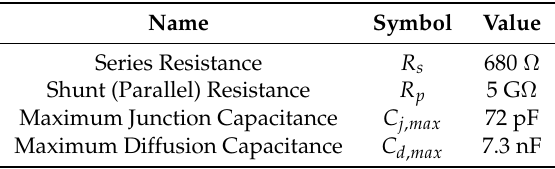
Figure 3. The photodiode equivalent circuit. The current source I pv outputs relative to the luminous intensity. The parasitics include the series resistance R s , shunt resistance R p , junction capacitance C j , and diffusion capacitance C d . R L and C L represents the load resistance and capacitance, respectively. Table 2. Estimated SFH206K parasitics.